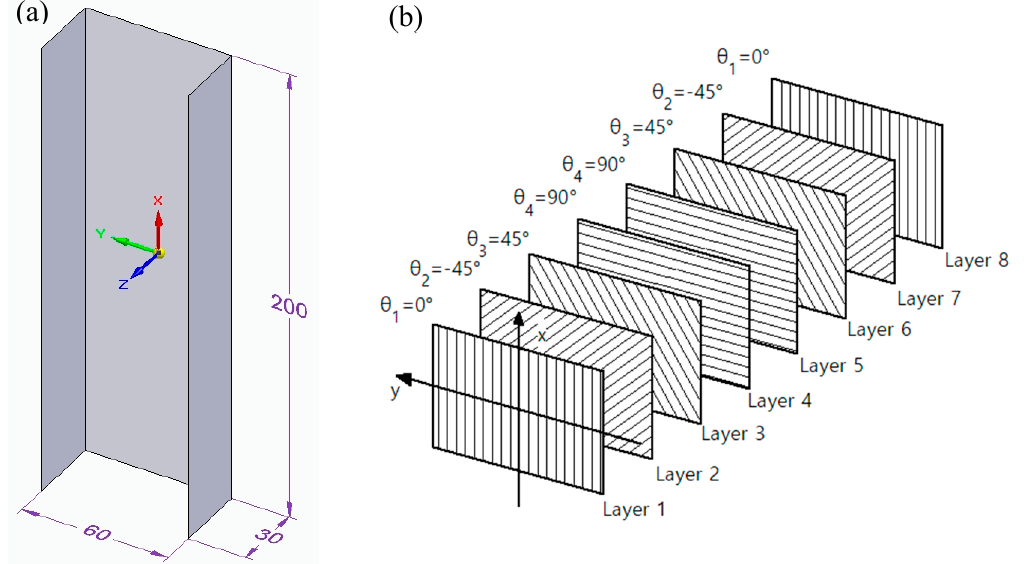
Figure 1. Examined composite structure: ( a ) geometrical model; ( b ) exemplary arrangement of the laminate layers, configuration [0/ − 45/45/90]s (own work).